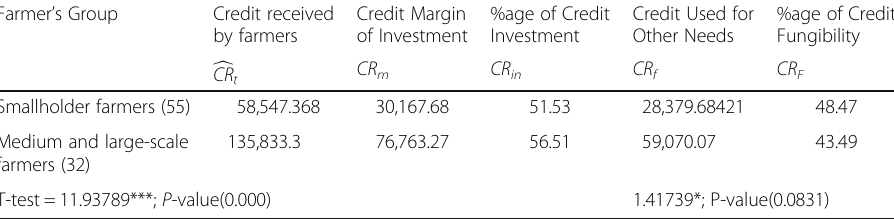
Table 2 Credit Margin of Investment in the Agricultural Sector and Credit Fungibility Farmer ’ s